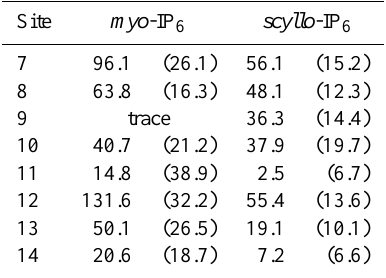
Table 3. Concentrations of two inositol hexakisphosphate isomers as determined by solution 31 P NMR spectroscopy within group B (low-pH, low-organic-matter) wetlands. Values represent concen- trations µgPg − 1 (% of